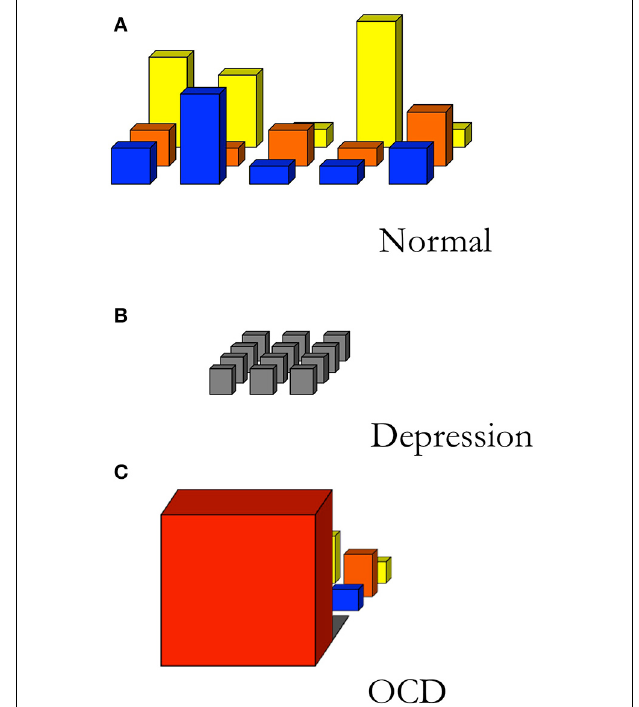
FIGURE 2 | Sketch of different fields of relevant affordances. (A) A normally structured, differentiated field of affordances. (B) The field of affordances of a depressed person. (C) The field of affordances of an OCD-patient. Creative Commons license applies (de Haan et al.,